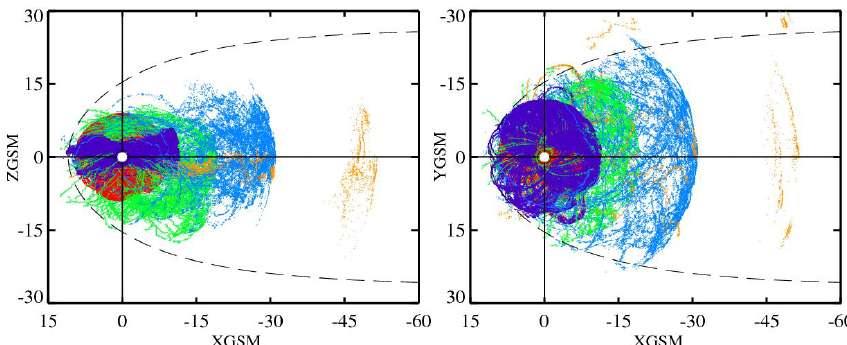
Fig. 12. Spatial coverage of the magnetosphere by space magnetometer data of the Polar (red), Geotail (light blue), Cluster (green), Themis-A, -D, -E (dark blue), and Themis-B, -C (yellow) spacecraft. The data set comprises 241,418 data records corresponding to 123 storm events between 1996 and 2012, with peak negative SYM-H index values not exceeding -200 nT. Equatorial and noon-midnight projections are shown in the left and right panels, respectively.